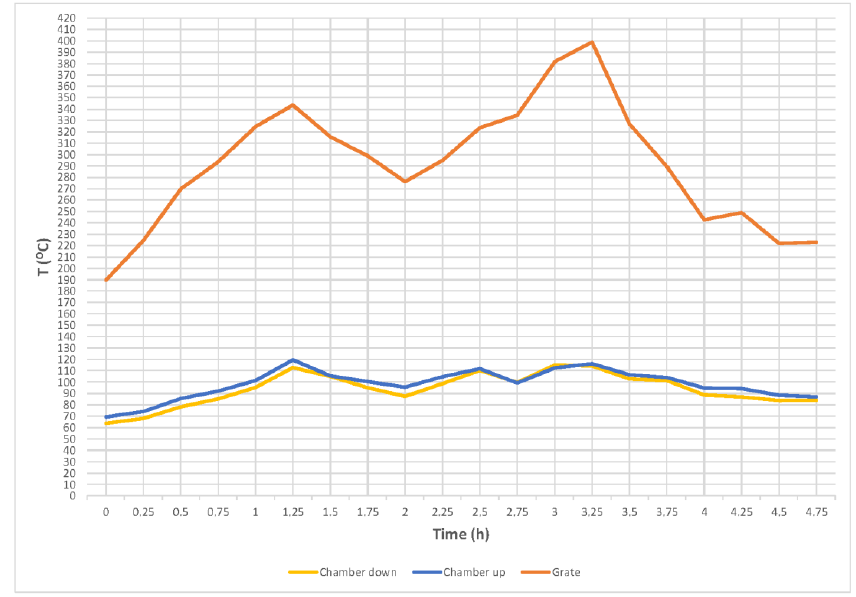
Figure 2. The temperature values (grate, top and bottom of the smoke chamber) obtained during smoking of medium ground sausages in variant B.